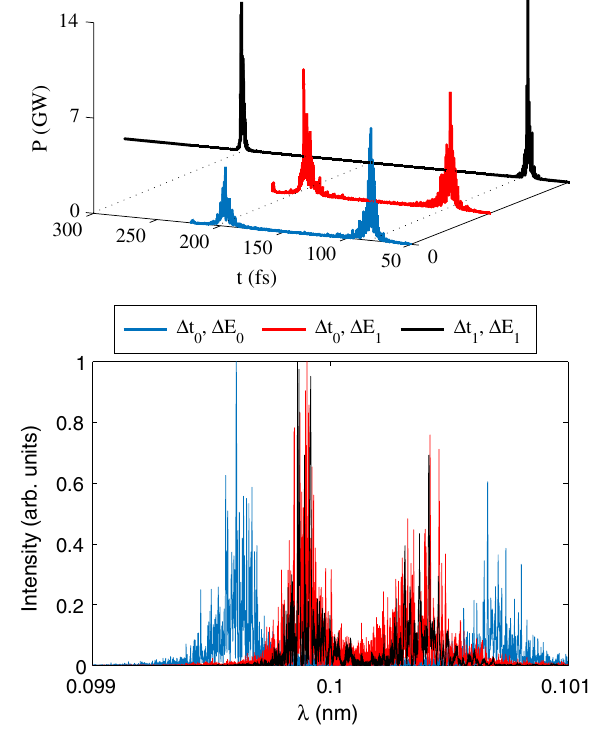
FIG. 4. Power of the emitted radiation along the longitudinal coordinate of the beams (top) and corresponding spectra (bot- tom). The subscript 0 refers to the reference case. Results corresponding to configurations with a different time delay Δ t Δ E 1 , and energy separation 1 obtained changing the semigap a of the corrugated plate and the phase of the accelerating cavities downstream of BC2, respectively, are also shown. More dis- cussion can be found in subsection III C.